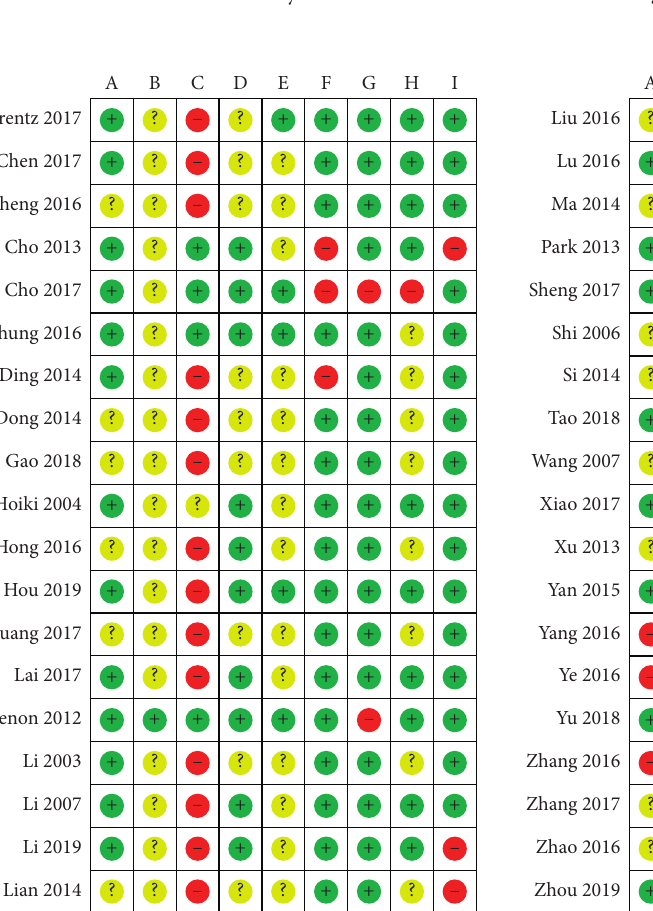
Figure 2: Summary of risk of bias for each domain among the 39 included studies.